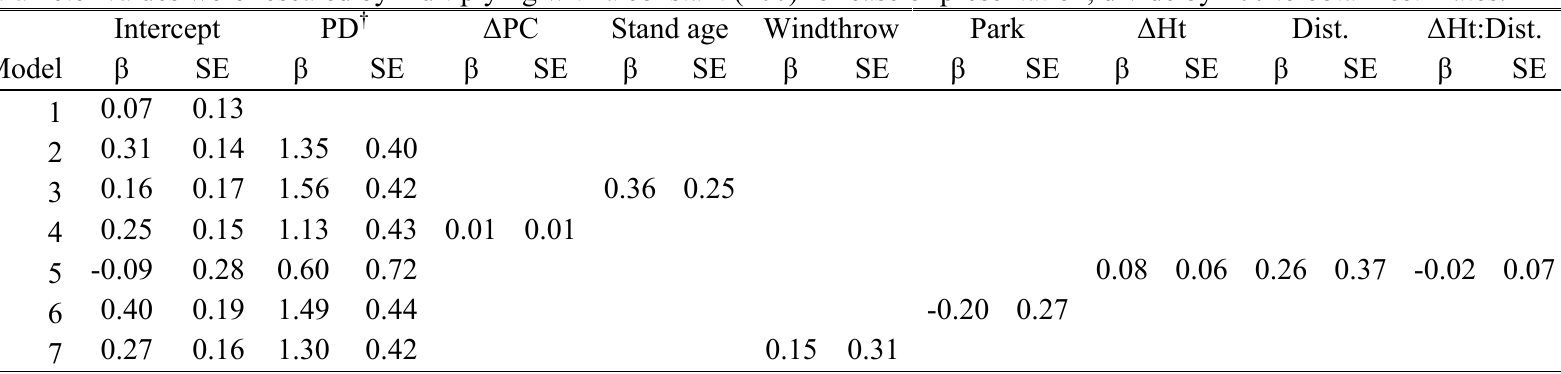
Table A2.9 Parameter estimates for models examining variation in stand-level trends (between circa 1994 and 2014) in abundance Chipping Sparrow in aspen dominated mixedwood forests in central Saskatchewan. 85% Confidence Intervals can be obtained as β ± 1.44* SE. NOTE: Parameter values were rescaled by multiplying with a constant (100) for ease of presentation, divide by 100 to obtain